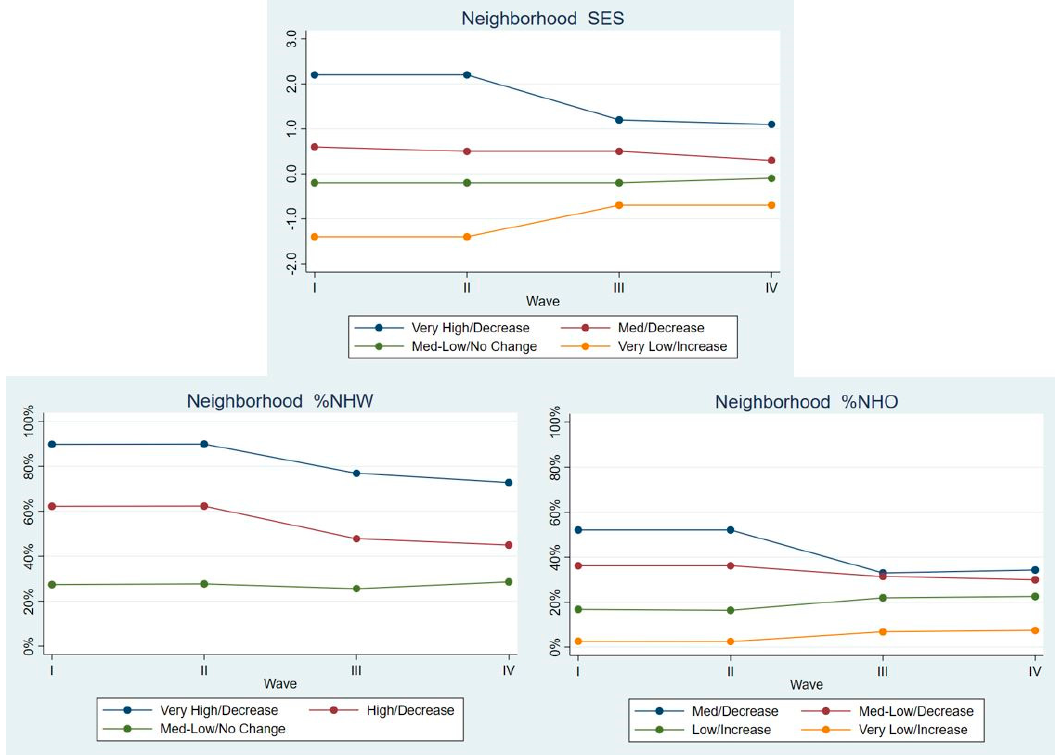
Figure 4. Latent class means for each neighborhood characteristic by Wave, non-Hispanic Others.